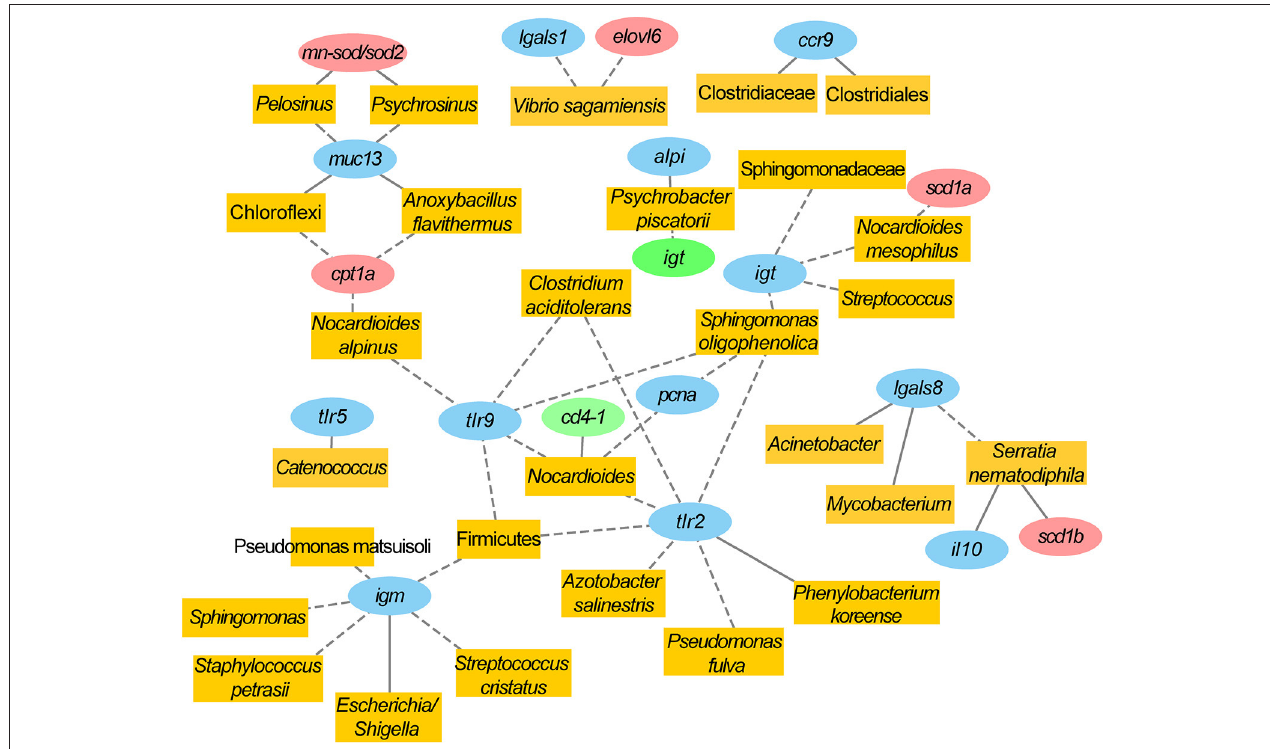
FIGURE 7 | Correlation network showing significant positive (straight lines) and negative (dotted lines) correlations (Spearman, P < 0.01) between discriminant OTUs (yellow) and differentially expressed genes (DEG) in the anterior intestine (blue). Differentially expressed genes in the head kidney (green) and liver (red) with common interaction with anterior intestine gene—OTU correlations are also